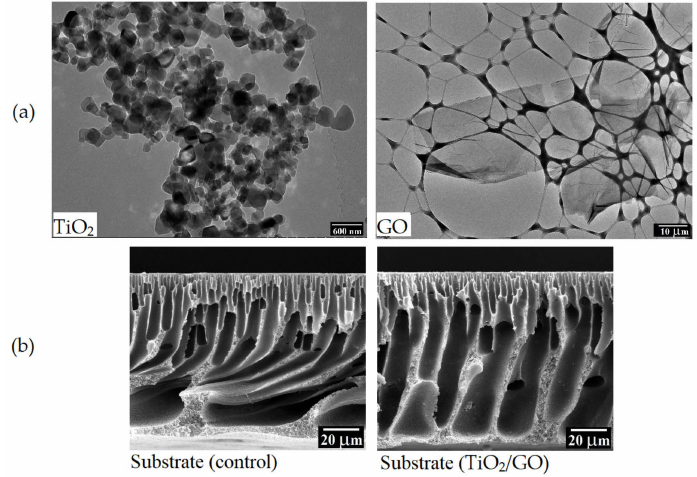
Figure 9. ( a ) Transmission electron microscopy (TEM) pictures of TiO 2 and GO nanomaterial; ( b ) Scan- ning electron microscopy (SEM) pictures of a substrate (control) and substrate (TiO 2 /GO). Repro- duced from reference [86] with permission from Elsevier (2017).